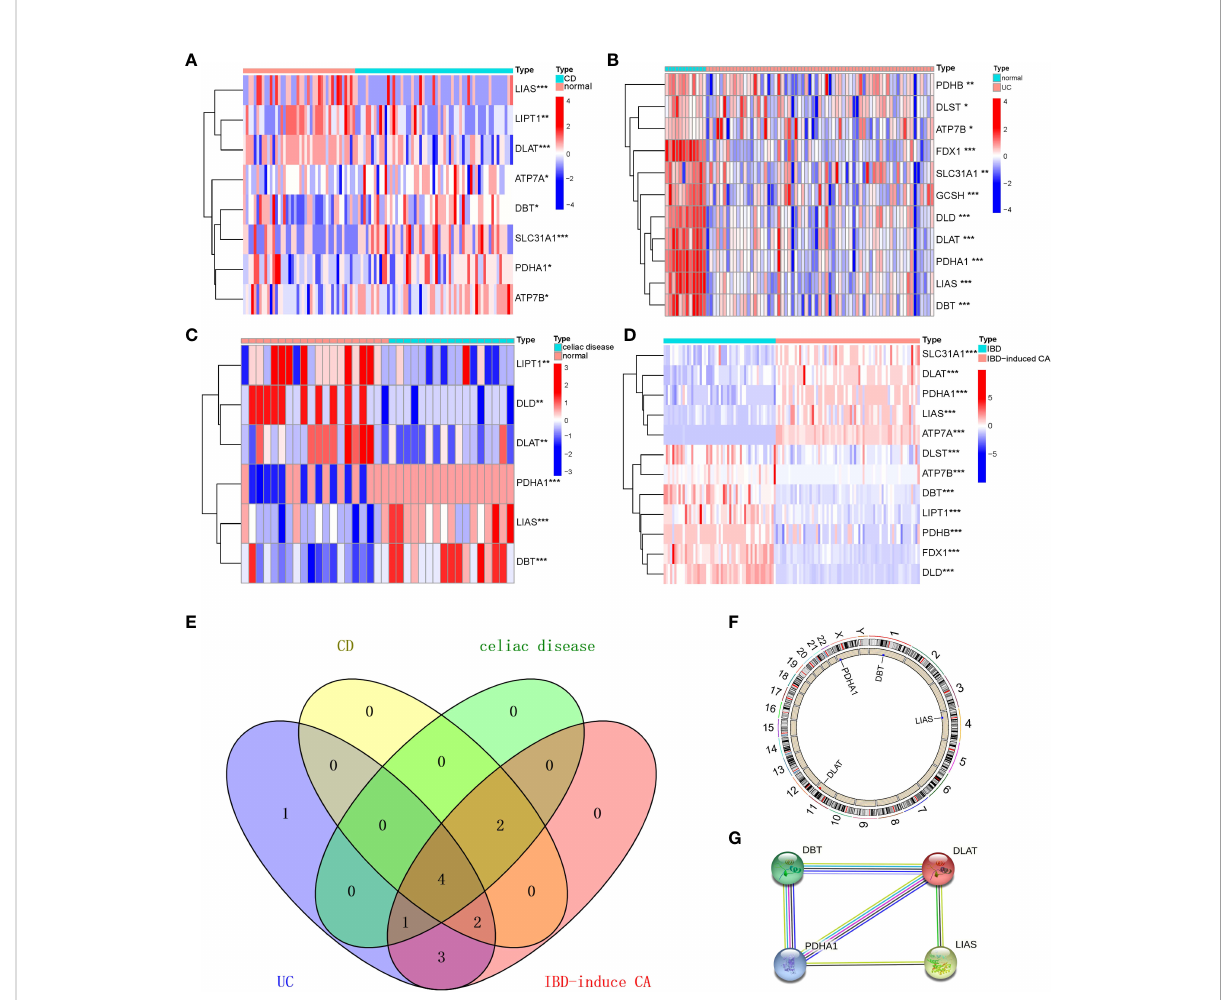
FIGURE 1 Identi fi cation and brief description of cuproptosis-related DEGs shared in Crohn ’ s Disease (CD), Ulcerative Colitis (UC), Celiac Disease (CEL), and IBD-induced cancer (IBD-CA). (A – D) Heatmap showing expression pro fi les for cuproptosis-related DEGs. Asterisks indicate signi fi cances: *p ≤ 0.05, **p ≤ 0.01, ***p ≤ 0.001. (E) Venn diagram shows the number of DEGs and intersected DEGs among the conditions including CD, UC, CEL, and IBD-CA. (F) Circos diagram reveals the positions of cuproptosis-related overlapping genes in chromosome. (G) The protein – protein interaction network shows inner association of these